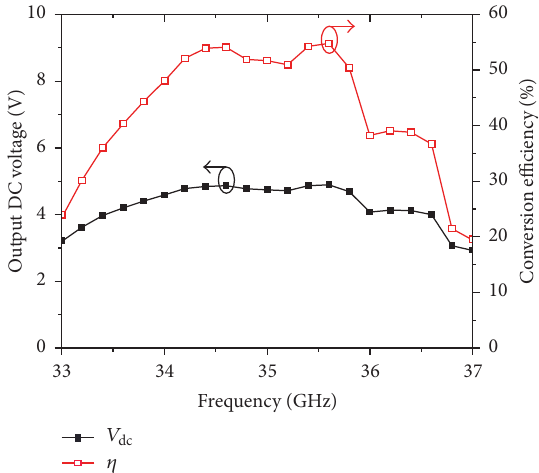
Figure 4: Measured reflection coefficient |𝑆 11 | versus frequency, 𝑃 = 10 dBm, and 𝑅 = 550 Ω . in 𝐿